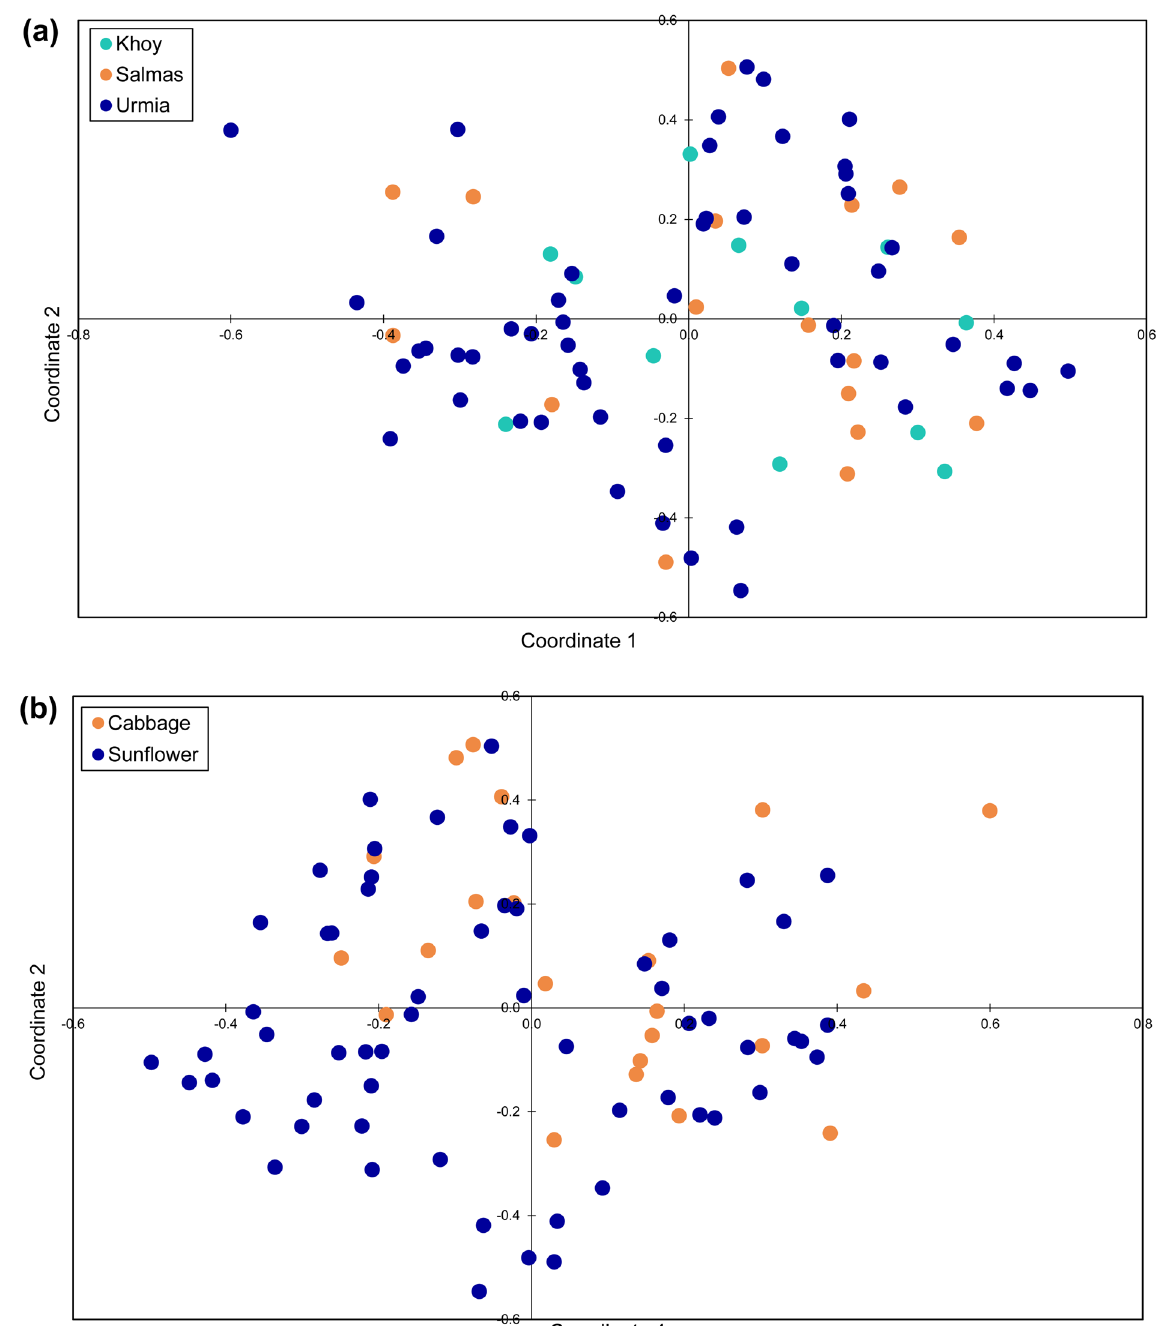
Figure 3. Principal coordinate analysis for ISSR multilocus genotypes (MLGs) of Sclerotinia sclerotiorum from geographic ( a ) and host ( b ) populations using Jaccard similarity